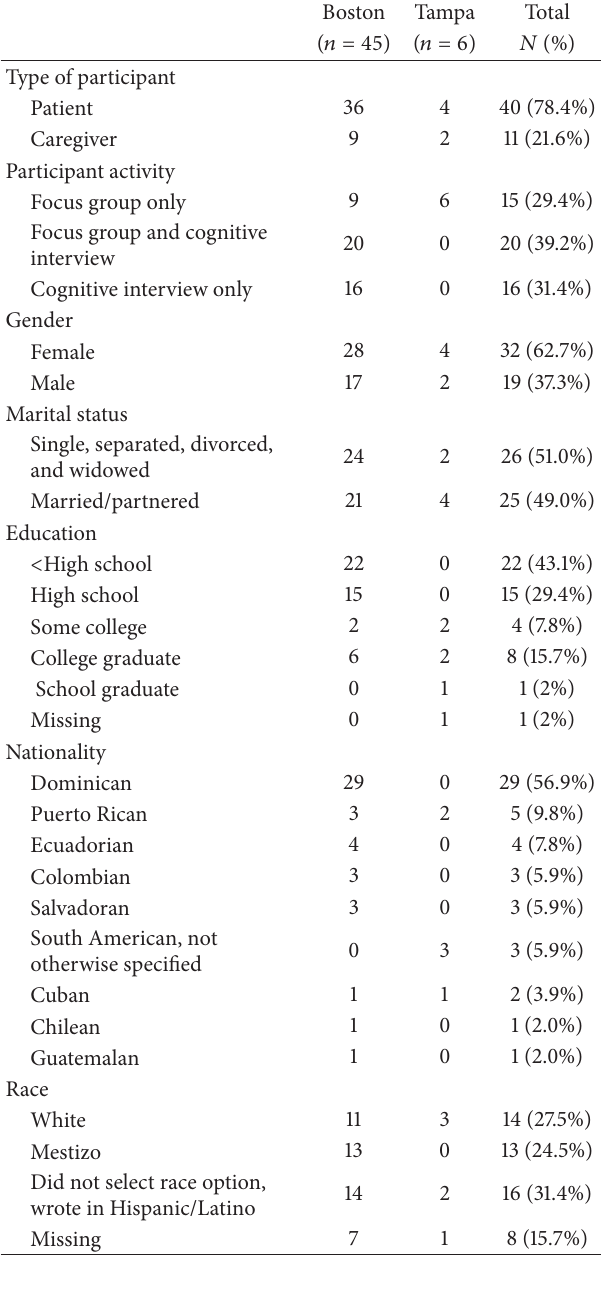
Table 2: Demographic characteristics and participant activity ( 𝑁 = 51